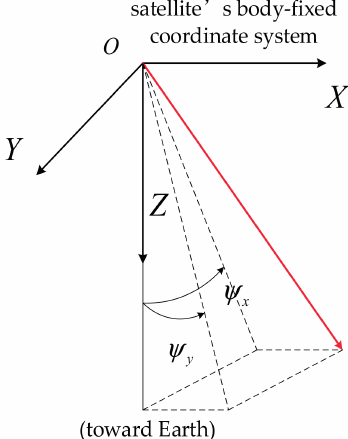
Figure 2. Viewing angle of each charge-coupled device (CCD) in the satellite’s body-fixed coordinate